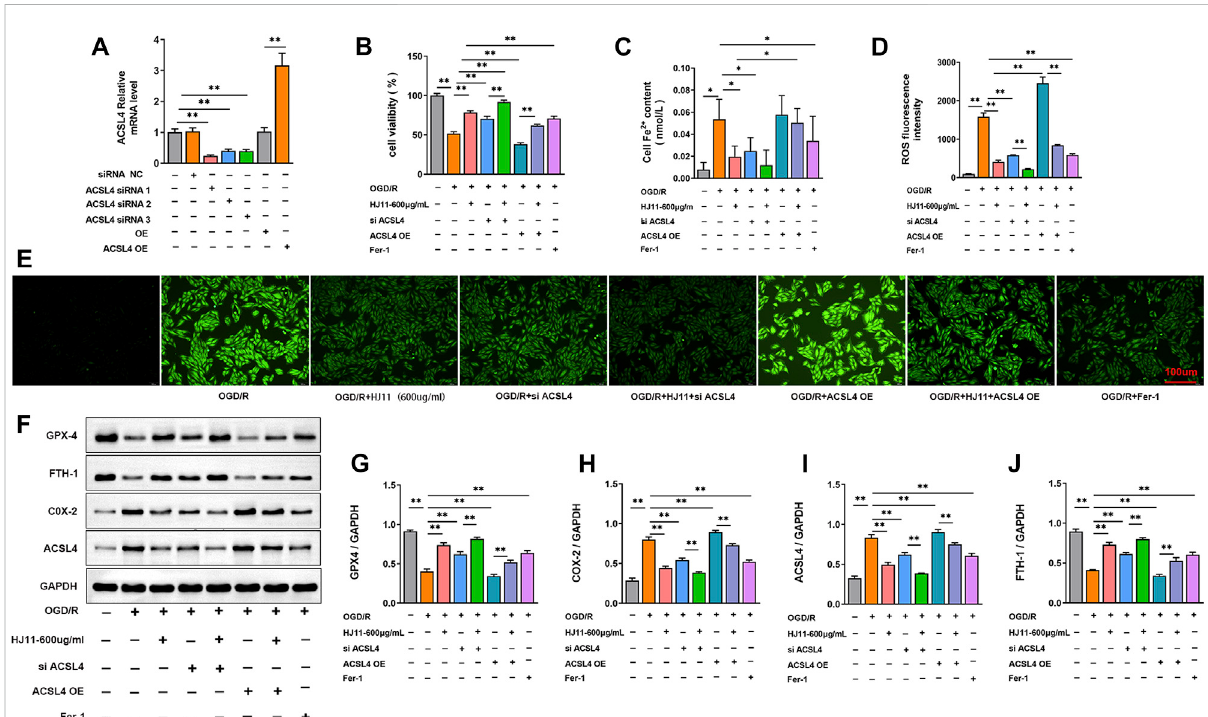
Effects of HJ11 decoction and ACSL4 on OGD/R-triggered injury in H9c2 cells. (A) Transfection ef fi ciency detection by quantitative reverse transcription – polymerase chain reaction (qRT-PCR) assay indicating that ACSL4 small interfering RNA (siRNA) and pcDNA3.1-ACSL4 vectors were successfully transfected into H9c2 cells. (B) Cell Counting Kit-8 assay showing that ACSL4 overexpression reversed the promoting effect of HJ11 decoction on the viability of oxygen glucose deprivation-reperfusion (OGD/R) – induced H9c2 cells. (C) ACSL4 overexpression counteracted the suppressing effect of HJ11 decoction on the iron accumulation level in the OGD/R-induced H9c2 cells. (D,E) Dichloro-dihydro- fl uorescein diacetate staining and statistical analysis indicating that ACSL4 overexpression abrogated the inhibitory effect of HJ11 decoction on the production of reactive oxygen species in the OGD/R-induced H9c2 cells. Scale bar: 100 µm. (F – J) Representative western blot images of ferroptosis-associatedproteinsinH9c2cells.StatisticalanalysisofwesternblotsimplyingthatACSL4overexpressionreversedthesuppressingeffect of HJ11 decoction on the expression of ACSL4 and COX2 proteins and the promoting effect of HJ11 decoction on the expression of FTH1 and GPX4 proteins in the OGD/R-induced H9c2 cells. * p < 0.05. ** p < 0.01. *** p < 0.001. Data are shown as mean ± standard deviation. N = 3 for each